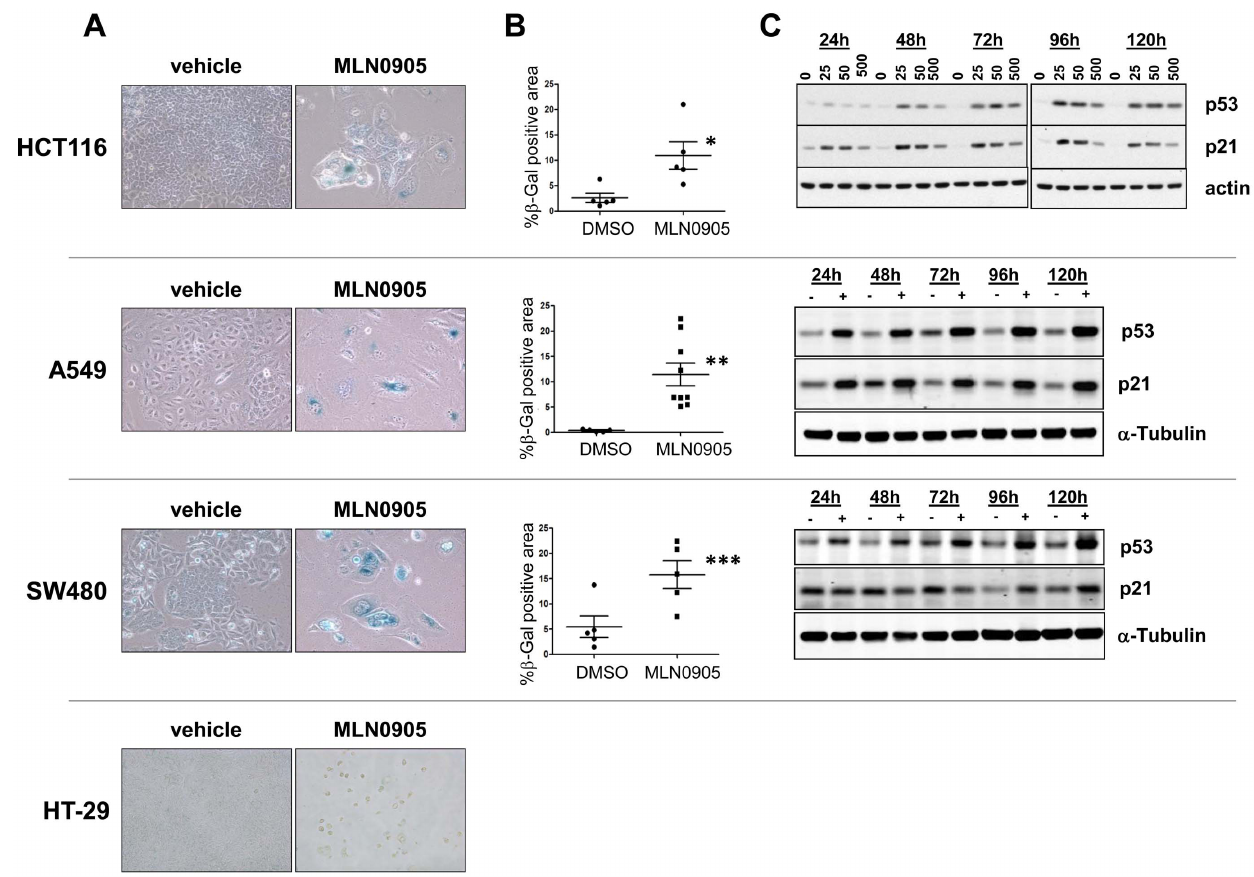
Figure 5. Plk1 inhibition leads to senescence in multiple cell lines. A) Cells were treated for two weeks with MLN0905 (50 nM for HCT116, 30 nM for A549, 20 nM for SW480 and HT-29) and then stained for b -galactosidase activity. B) b -galactosidase staining was then quantified in senescent cells and represented as % area (shown is mean 6 SD; *p=0.0159, **0.0033 and ***0.032 by a two-tailed Mann-Whitney test).